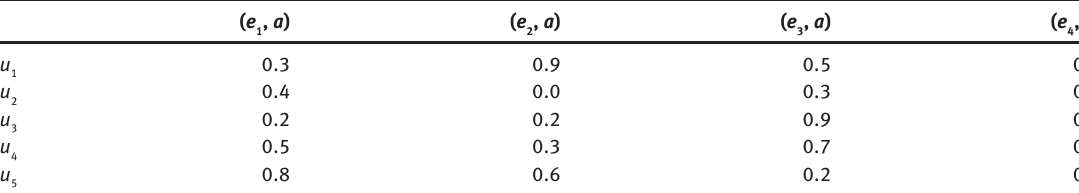
Table 1: Opinions of Expert a